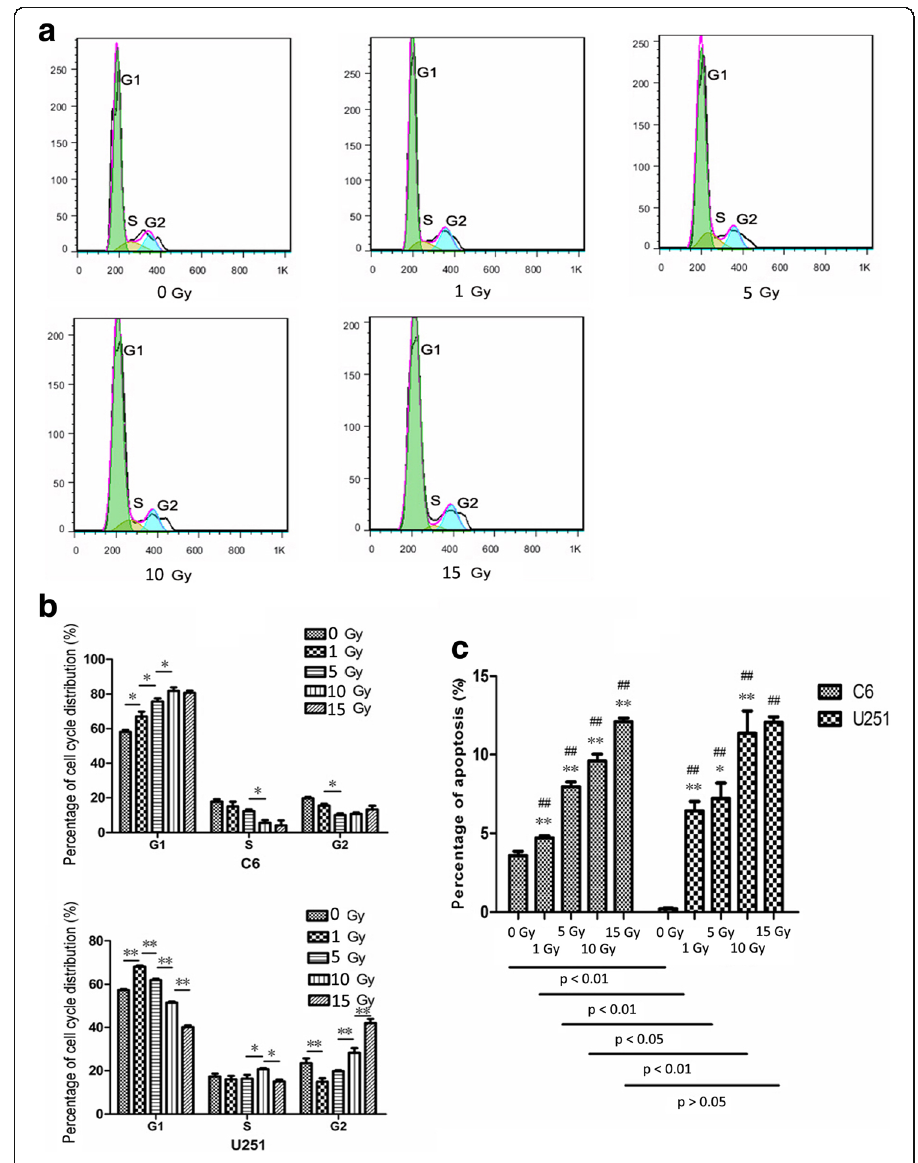
Fig. 2 Cell cycle distribution and apoptotic rates of the two cell lines. a – Flow cytometry was performed and data were analyzed using FlowJo 7.6. A representative series of cell cycle FACS histogramsfor C6 cells are shown. The cell cycle distribution ( b ) and apoptotic rate ( c ) were assessed. b – The percentage of cells at each stage of the cell cycle are shown for C6 and U251 cells.* p < 0.05, ** p < 0.01. c – The apoptotic rate increased with increasing X-ray irradiation. * p < 0.05, ** p < 0.01: comparisons with the previous group (e.g., 5 Gy and 1 Gy; 10 Gy and 5 Gy); # p < 0.05, ## p < 0.01: comparisons with the control group. The apoptotic rates of C6 were also compared with those for U251 cells for the same radiation dose. Statistical significance was determined as p < 0.05. This is shown in the bars under the